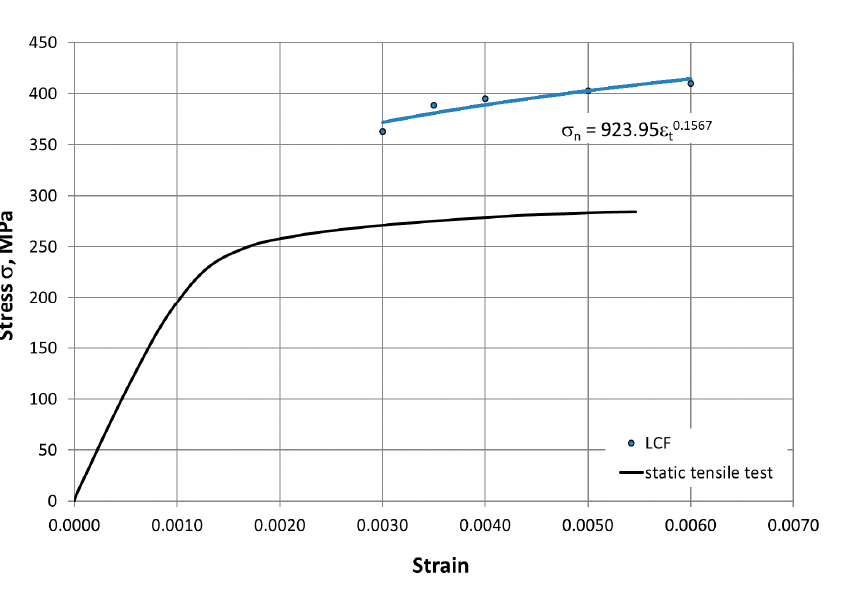
Figure 10. Cyclic strengthening curve for HR6W alloy at room temperature against a curve deter- mined in a static tensile test (LCF—Low Cycle Fatigue).